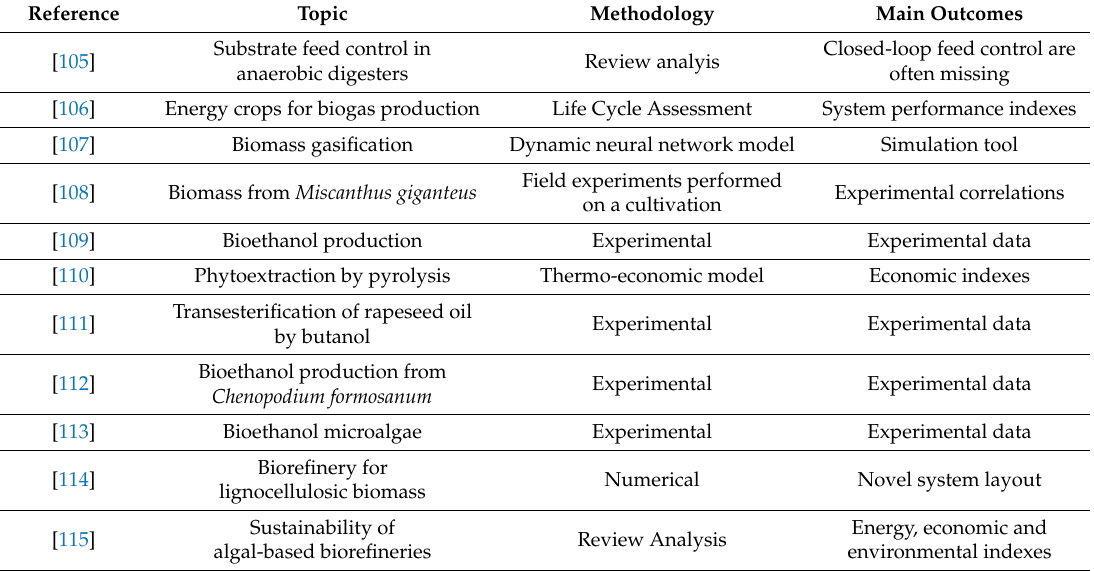
Table 4. Main topics, methodologies and outcomes of the previous SDEWES papers dealing with